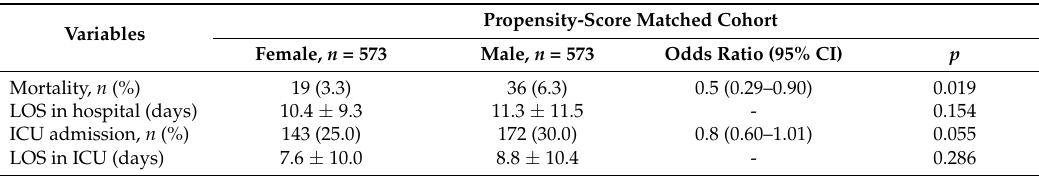
Table 3. Clinical outcomes of male and female patients with high-risk OSTA scores assessed using the propensity-score matching analyses after adjusting for age, comorbidity, mechanism, and injury severity score